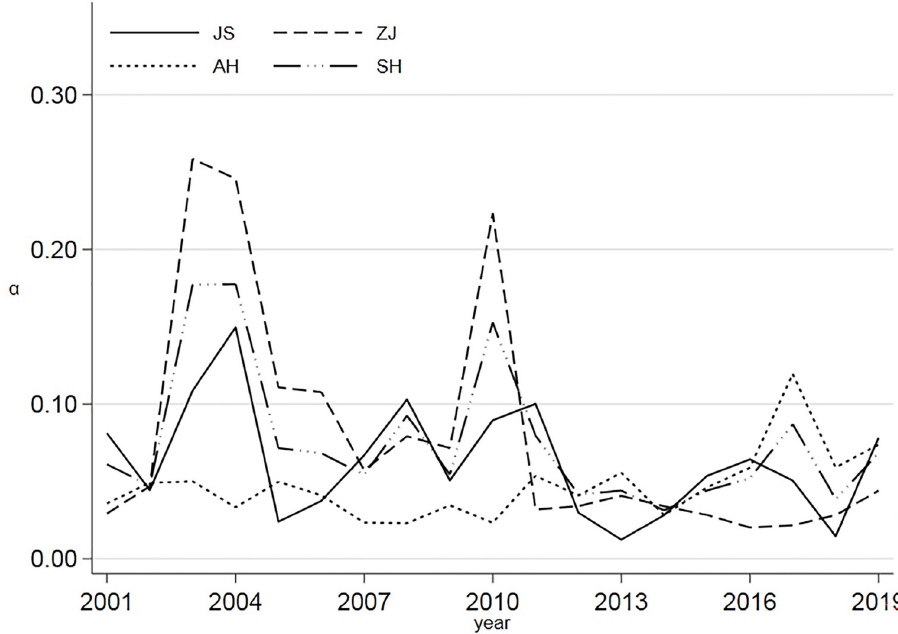
Fig 4. The trend of α convergence of provincial AGTFP in the YRD